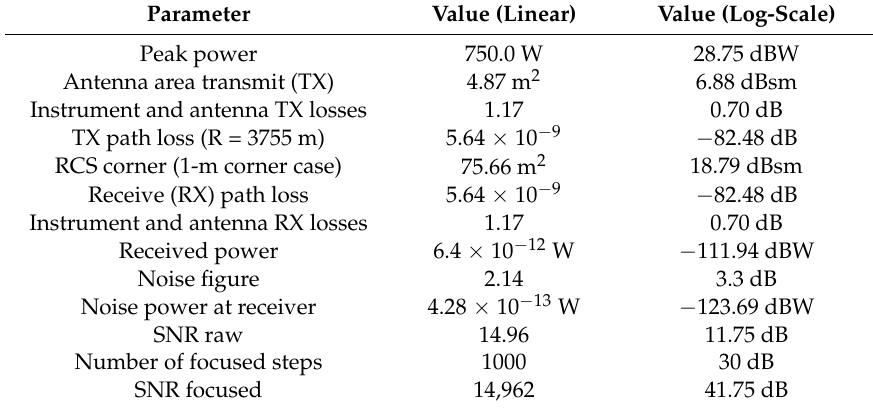
Table 2. Link budget computation and Signal to Noise Ratio (SNR) computation (ideal propagation media).